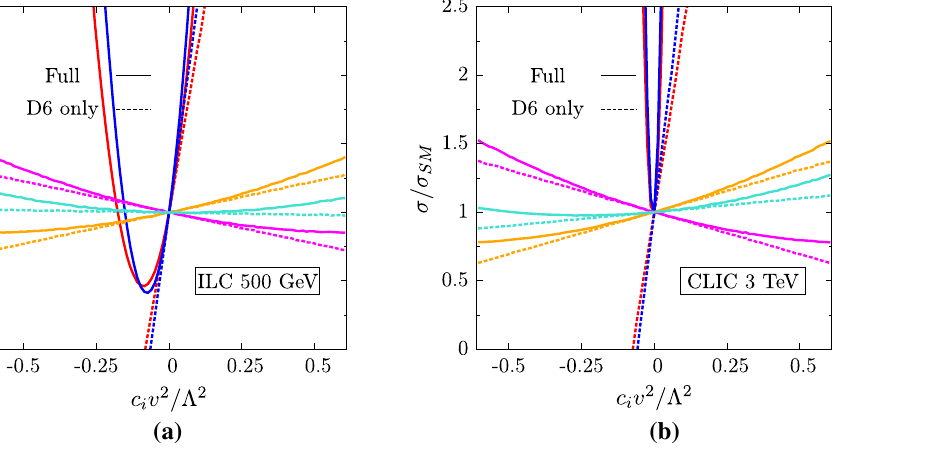
Fig. 4 a Ratio of the full SM e + e − to t ¯ t cross-section at GeV with the operators of Eq. (II.4) switched on individually to the NLO Standard Model estimate. The dashed lines show the contribution